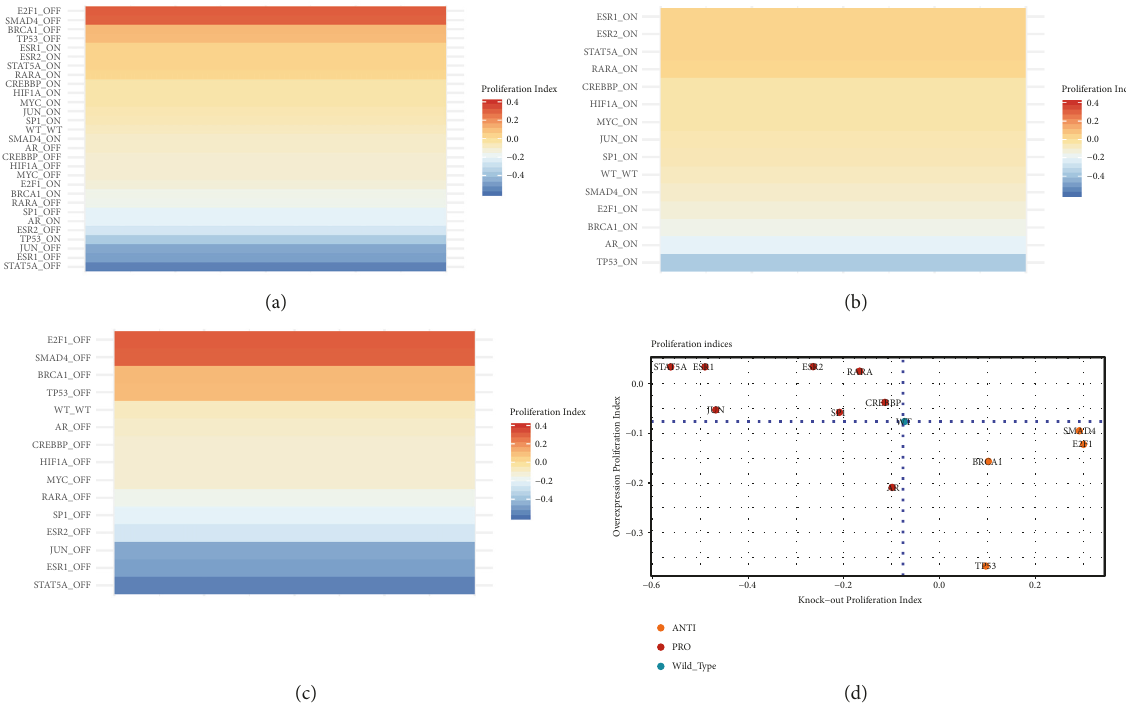
Figure 4: Proliferation indexes for single gene perturbations. Each column shows the PI values after a perturbation. (a) shows the set of overexpression and knockouts, (b,c) represent overexpression and knockout separately. (d) is a scatterplot showing the PI values of all genes after overexpressing and knocking out the